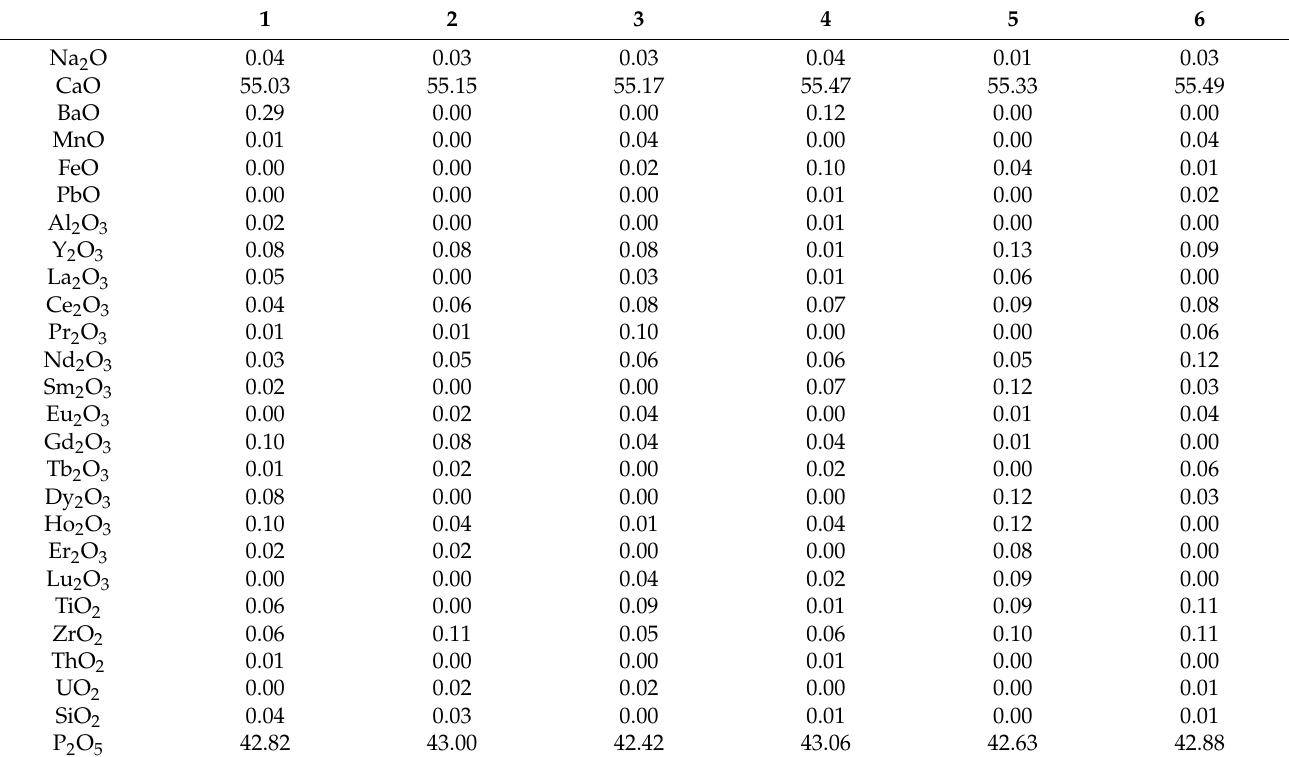
Table 14. Representative WDS microanalyses of fluorapatite from ˇCuˇcma (Majersk á